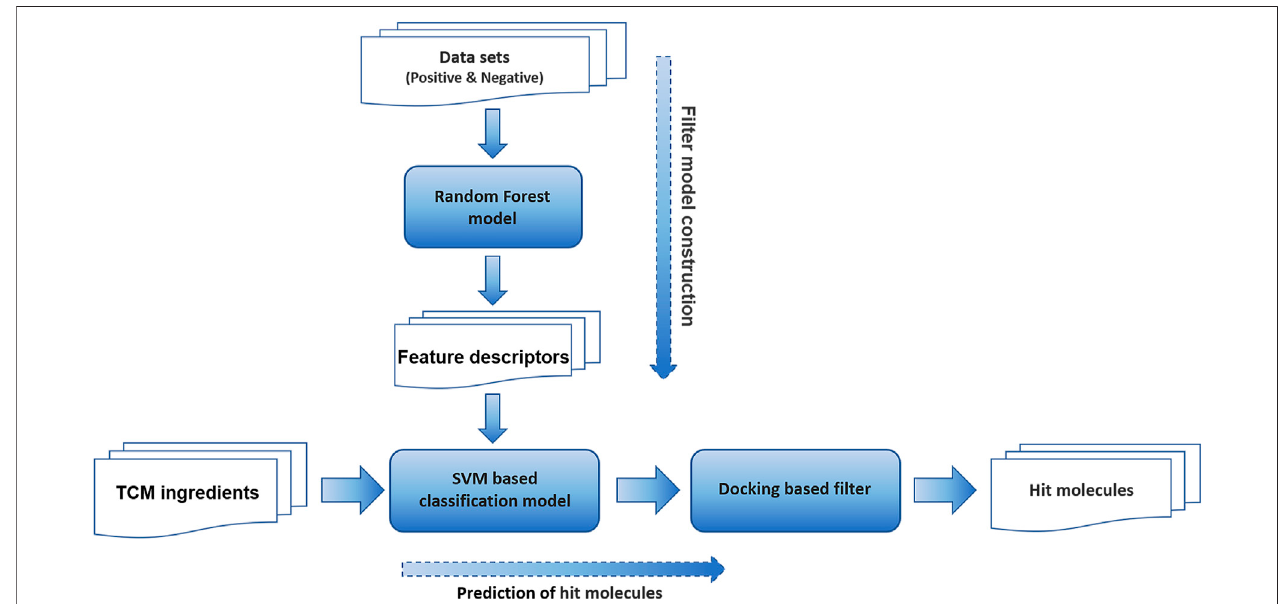
FIGURE 1 | The virtual screening work fl ow adopted in this